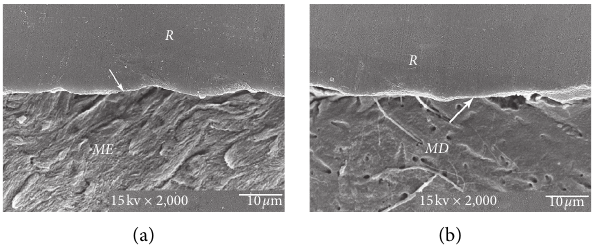
Figure 7: SEM micrograph of Clearfil Protect Bond-restored resin composite after chemical challenge, demonstrating the thin and degraded interfacial layer (arrowed) in the enamel (a) and dentin (b) (original × 2,000, ME � modified enamel, MD � modified dentin, and R �